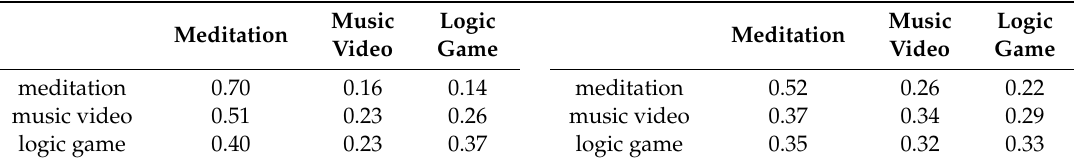
Table 19. Normalized confusion matrix for SVM classifier with RBF kernel, C = 1, γ = 1, and the dwt feature extraction scheme (left). Normalized confusion matrix for SVM classifier with RBF kernel, C = 0.01, γ = 0.1, and the dwt_stat feature extraction scheme